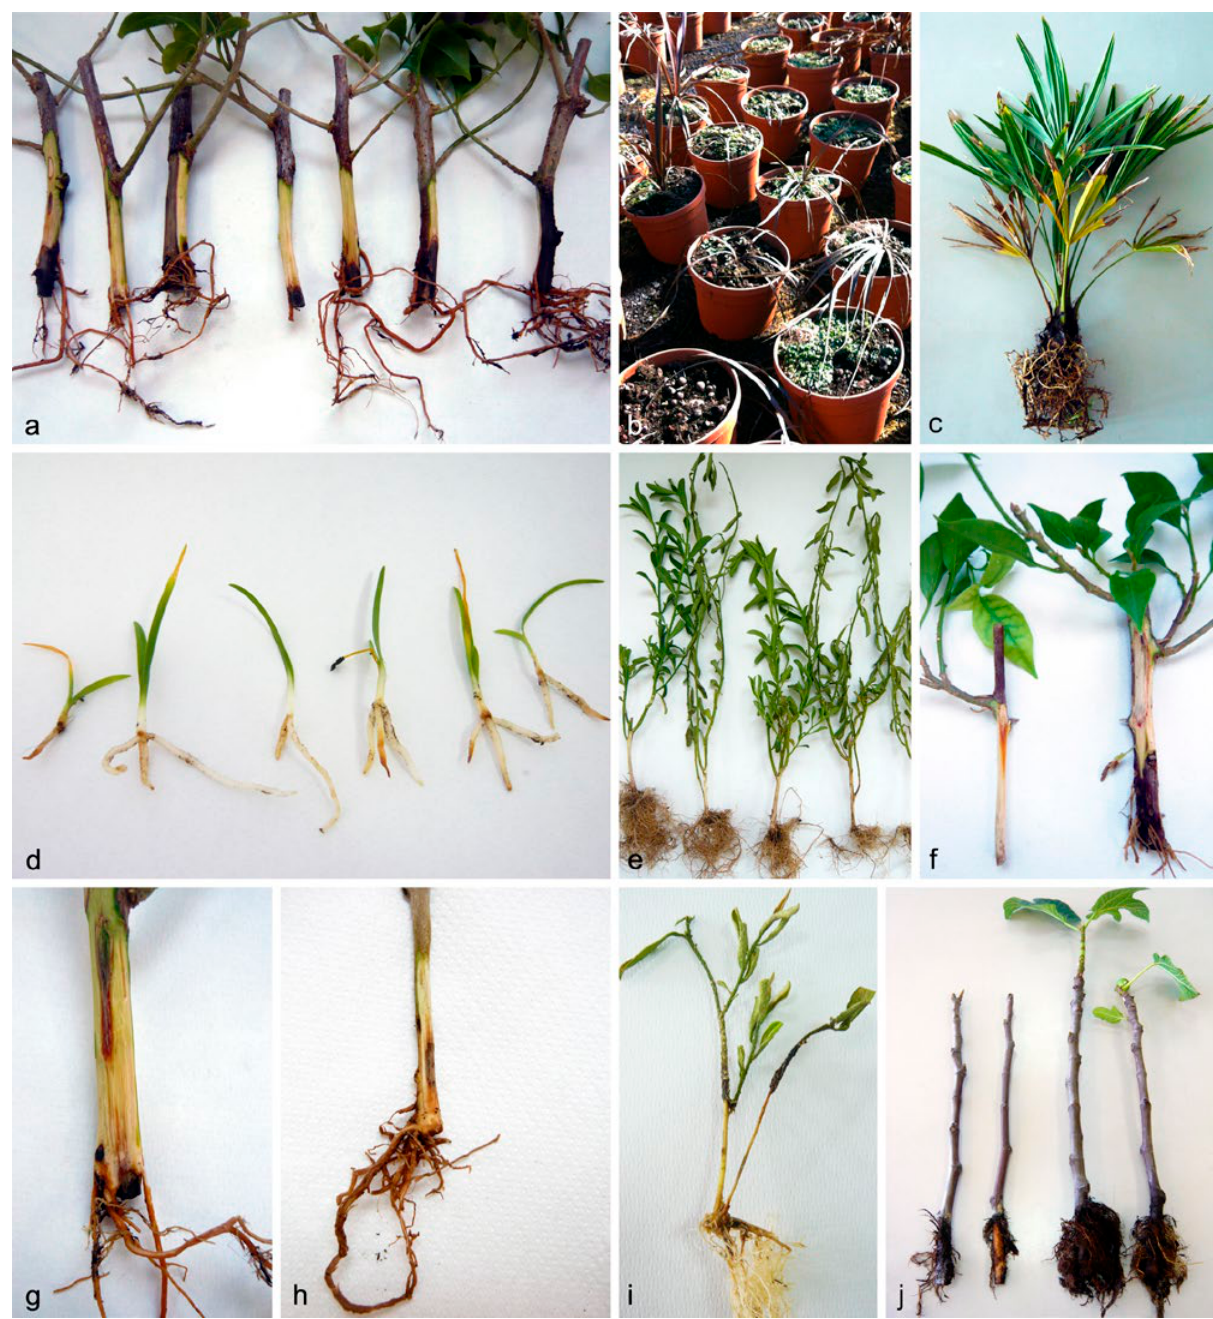
Figure 1. Natural and artificial symptoms referable to Fusarium and Neocosmospora spp. a, b . Wilt of Bougainvillea glabra cuttings (a) and Cordyline australis seedlings (b). c . Root rot with subsequent leaf chlorosis of Trachycarpus princeps . d . Damping-off of Agapanthus afri- canus . e . Wilt of Phyloteca myoporoides. F to i . Vascular discolouration and wilt after Fusarium oxysporum inoculation of Bougainvillea glabra (f and g), Eremophila laanii (h) and Phyloteca myoporoides (i). j . Crown and root rot caused by Neocosmospora solani (= Fusarium solani ) on Ficus carica (left) compared with control plants